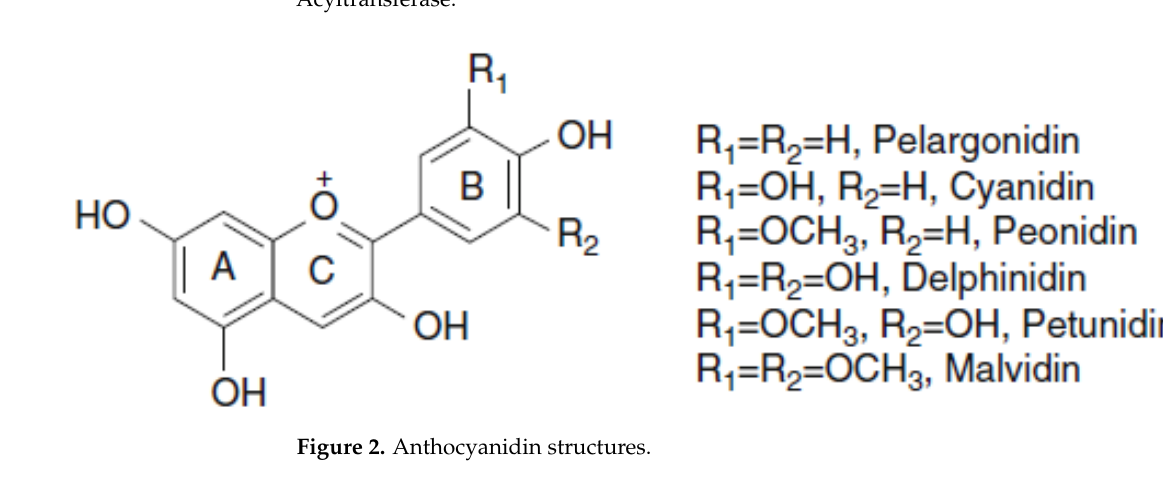
Figure 1. Biosynthesis pathway of anthocyanins in plants. PAL: Phenylalanine Ammonia Lyase, C4H: Cinnamate 4-hydroxylase, CPR: cyto-chrome P450 reductase, 4-CL: 4-coumaroyl-CoA ligase, CHS: Chalcone Synthase, CHI: Chalcone Isomerase, F3H: Flavanone-3-Hydroxylase, F3 (cid:48) H: flavonoid 3 (cid:48) - hydroxylase, F3 (cid:48) 5 (cid:48) H:Flavonoid 3 (cid:48) ,5 (cid:48) -hydroxylase, DFR: Dihydroflavonol 4-reductase, ANS: Anthocya- nidin Synthase, FGT: Flavonoid Glucosyltransferase, OMT: O-Methyltransferase, ACT: Anthocyanin Acyltransferase.